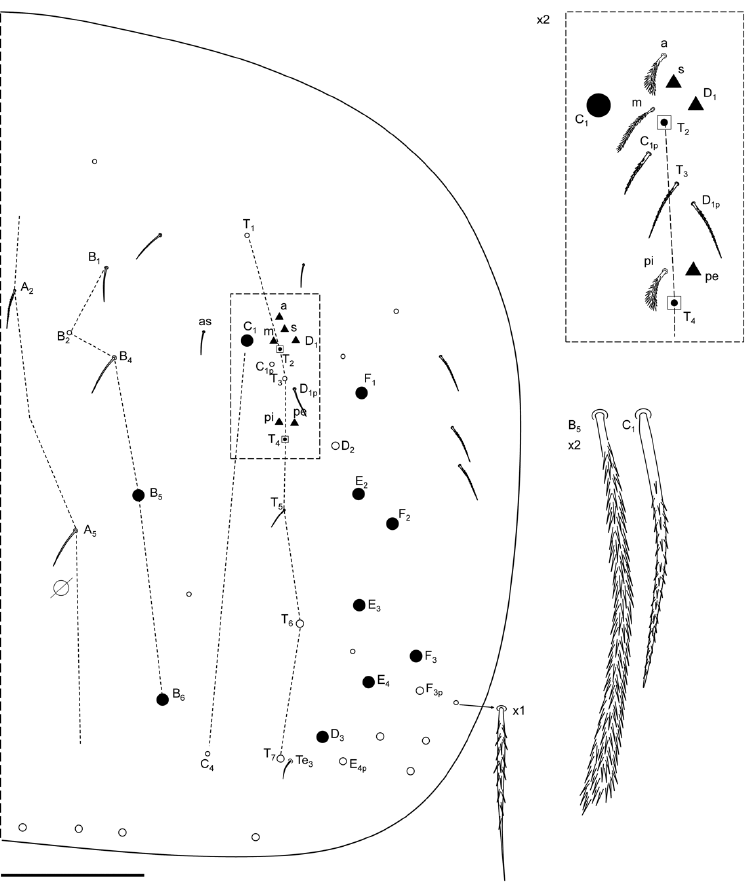
Figure 10. Pseudosinella impariciliata Baquero and Jordana sp. nov.: Abd IV chaetotaxy (scale bar, 0.1 mm).